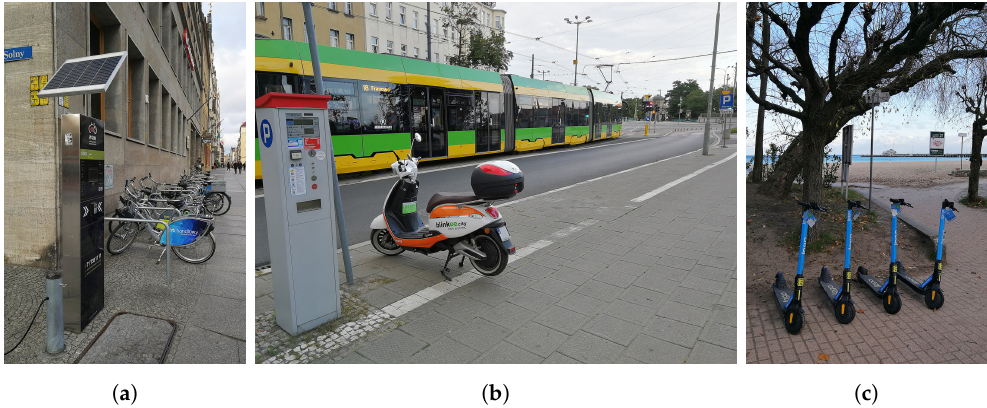
Figure 1. Examples of connected devices in cities in Poland. ( a ) Bike rental station in Wrocław on 10 December 2019; ( b ) parking meter, tram, and scooter in Pozna´n on 4 August 2019; ( c ) electric kick scooters in Sopot on 29 November